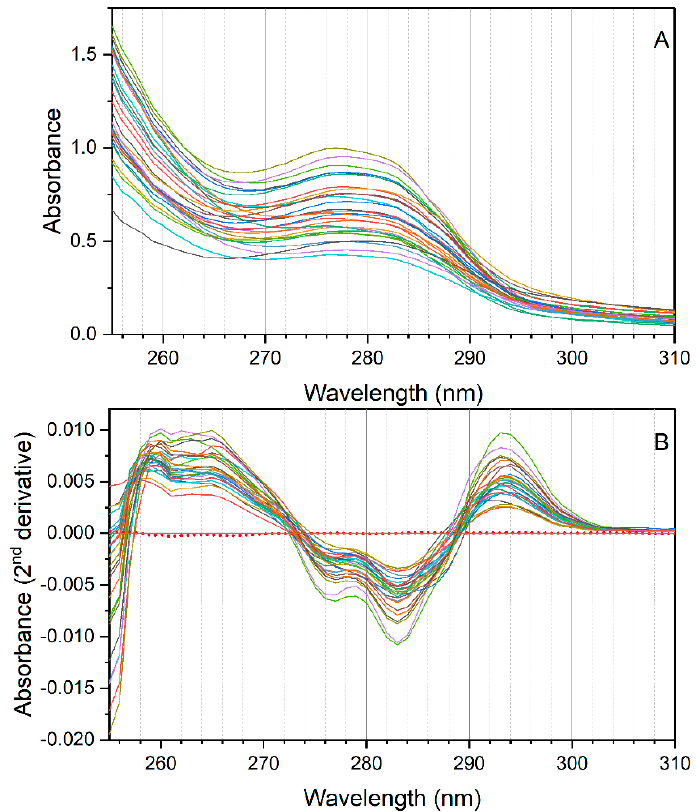
Figure 2. Spectra ( A ), and second derivatives of spectra ( B ) of the NADES extracts of the EVOO samples ( n = 26). The red dotted line in ( B ) reports the second derivative of the NADES extract of a sample of sunflower oil.